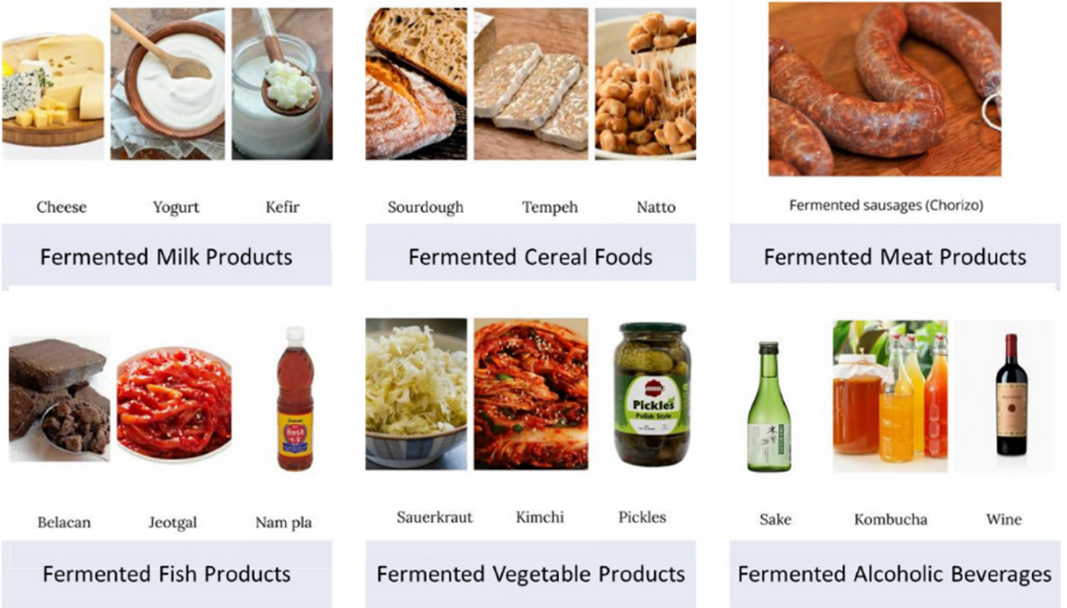
Figure 1. Examples of fermented foods and beverages based on divergent raw food substrates found around the world.